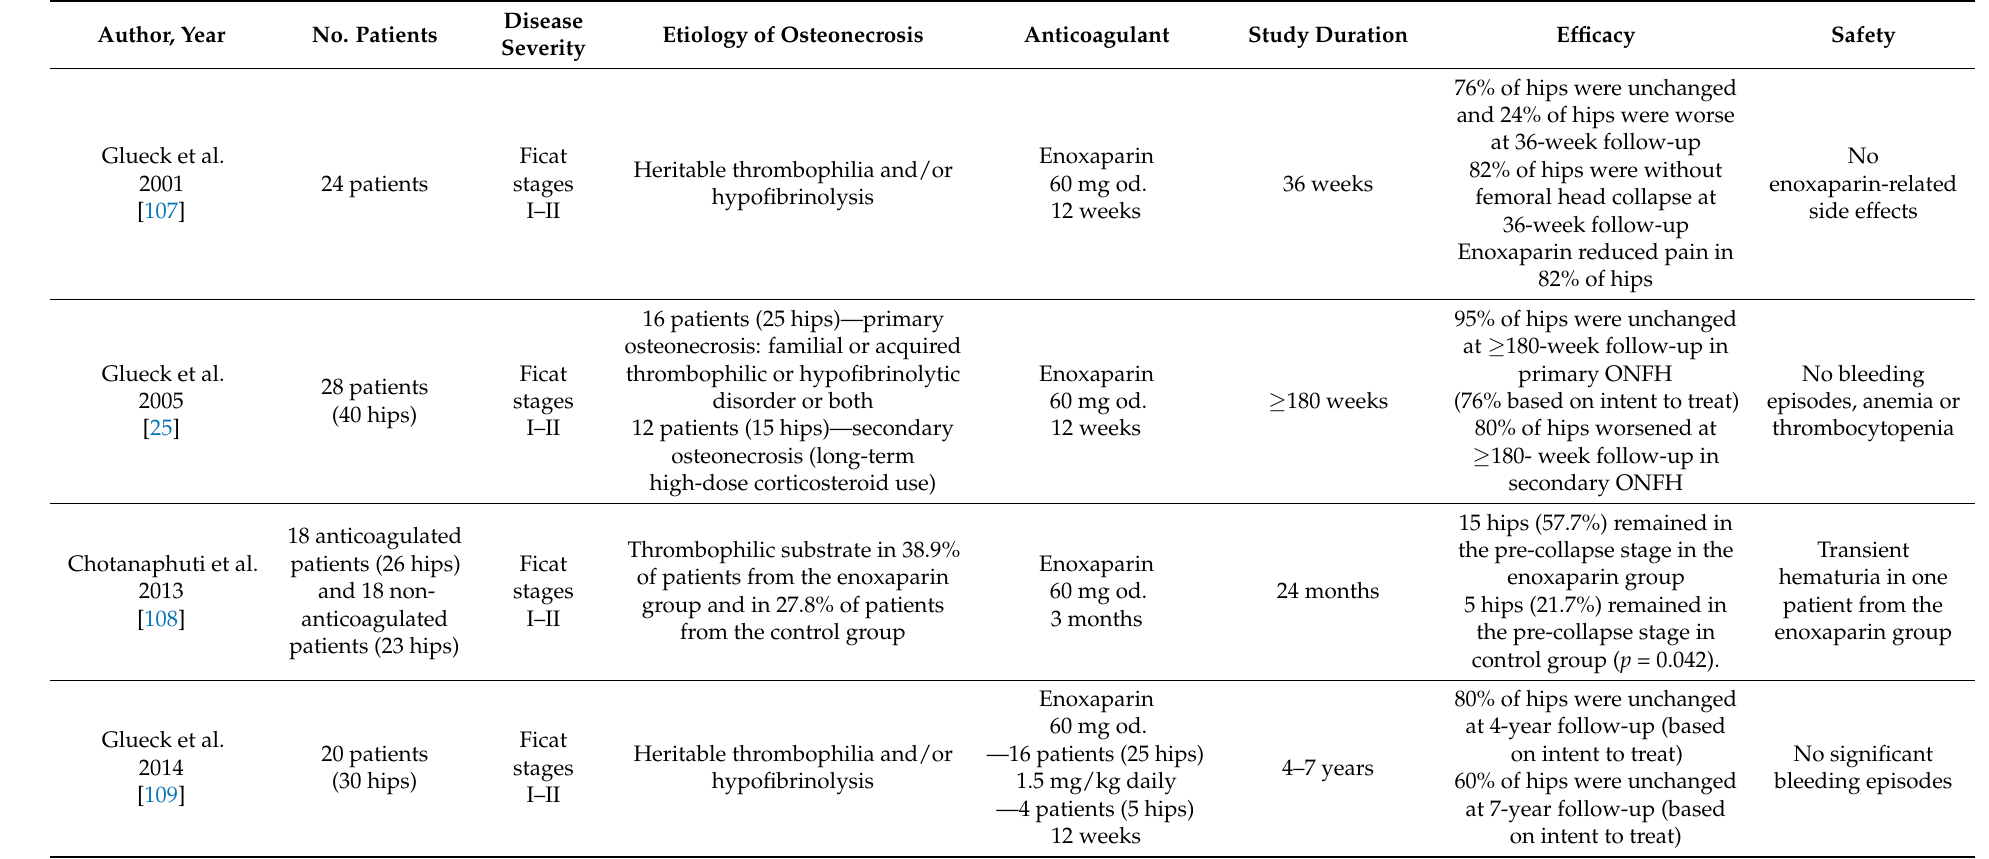
Table 1. Methods and outcomes of studies on the use of anticoagulants in patients with